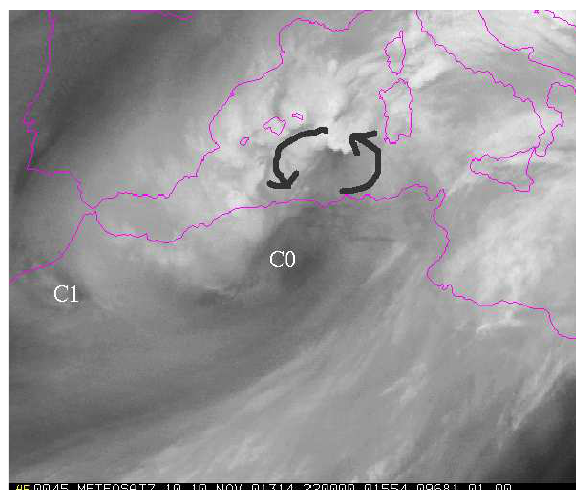
Fig. 2. Normalised Water Vapour METEOSAT7 image on 10 November 2001 at 22:00UTC. EUMETSAT